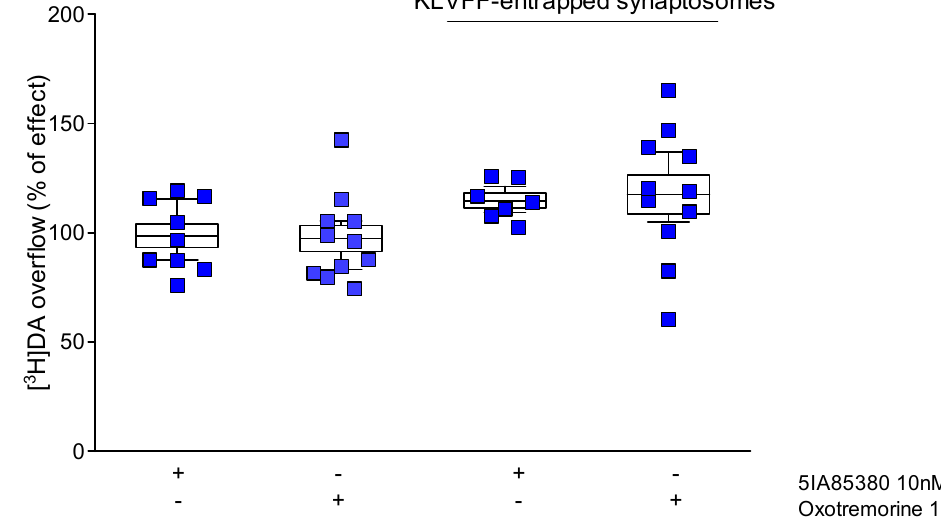
Figure 6. Effect of entrapped KLVFF on the nicotinic and muscarinic modulation of [ 3 H] dopamine overflow from striatal nerve endings. Data are mean ± SEM ( n = 8–12 per group).